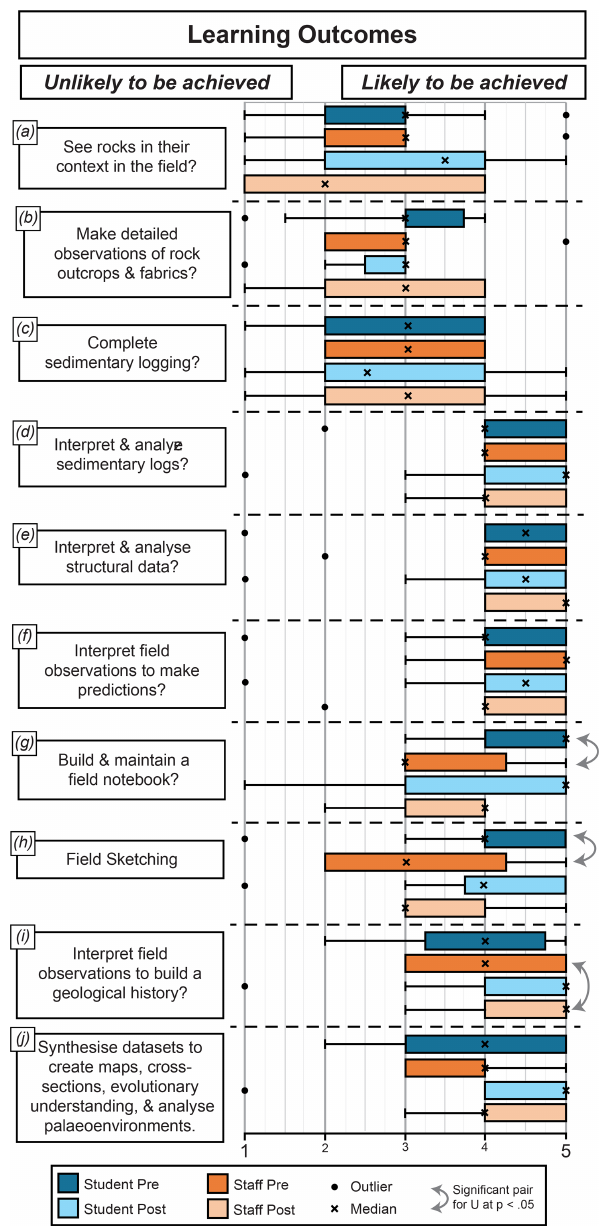
Figure 2. Quantitative responses to learning outcome statements. Panels (a) – (i) summarize staff and student responses to a series of statements related to learning outcomes on a scale of 1–5: 1 is un- likely to be achieved, and 5 is likely to be achieved. Responses are grouped by statement and presented as pre-course and post-course responses for the student and staff cohorts.